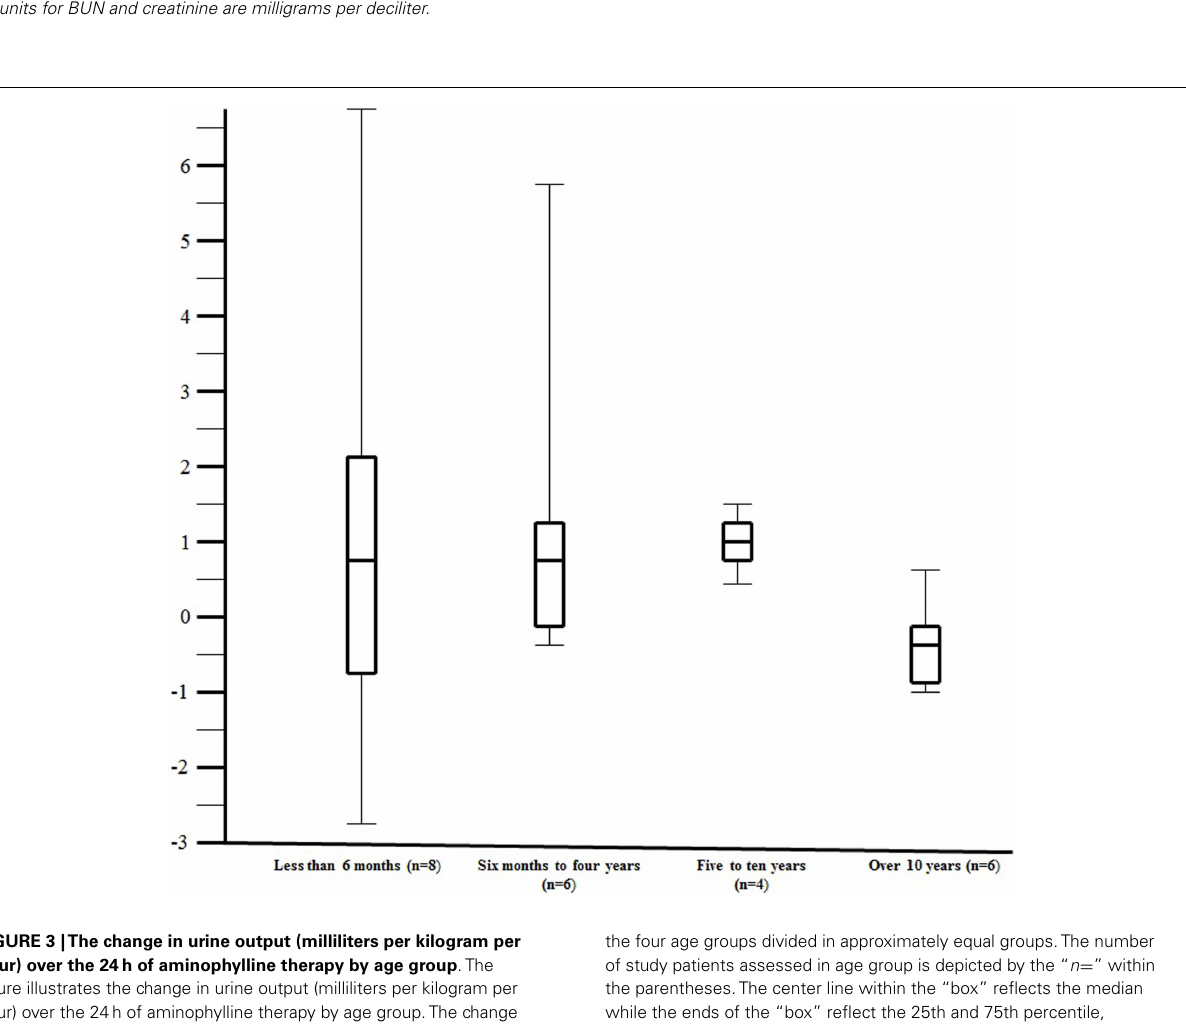
the four age groups divided in approximately equal groups.The number of study patients assessed in age group is depicted by the “ n = ” within the parentheses.The center line within the “box” reflects the median while the ends of the “box” reflect the 25th and 75th percentile, respectively.The “whiskers” extending from the box reflect the entire range of